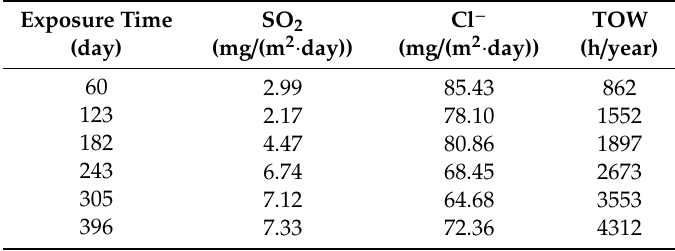
Table 3. Chloride and sulphur dioxide deposition rates and time of wetness recorded bimonthly at the test station over one year.